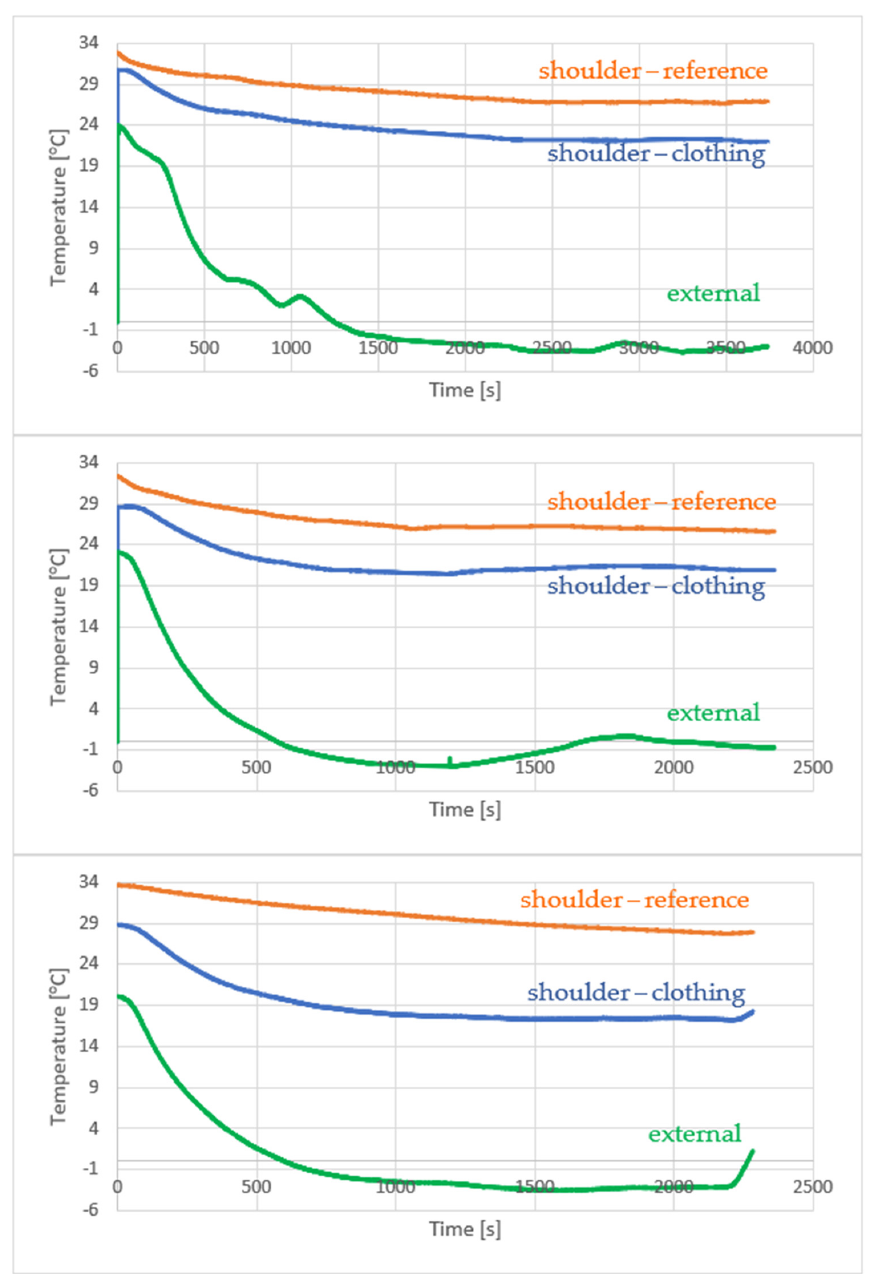
Figure 7. Temperature sensor readings: shoulder—reference (orange), shoulder—clothing (blue) and external (green) temperatures. From top: participants A , B and C . Note the different duration for participant A . The sudden rise of the external temperature reading for participant C at 2200 s is caused by leaving the chamber.